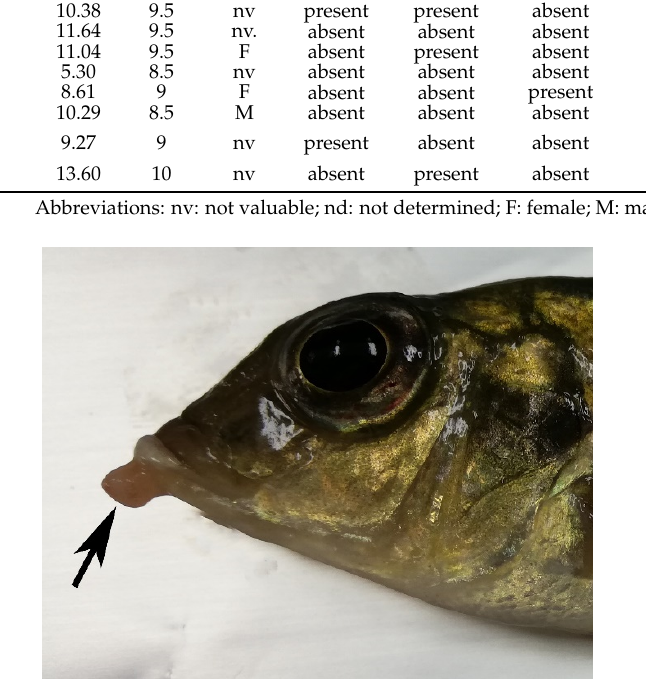
Table 1. Synoptic table of ornamental fish species investigated in this study.